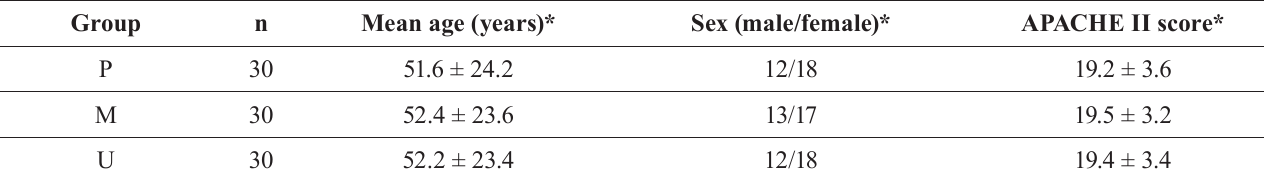
TABLE I - C omparison of patient characteristics among the three groups